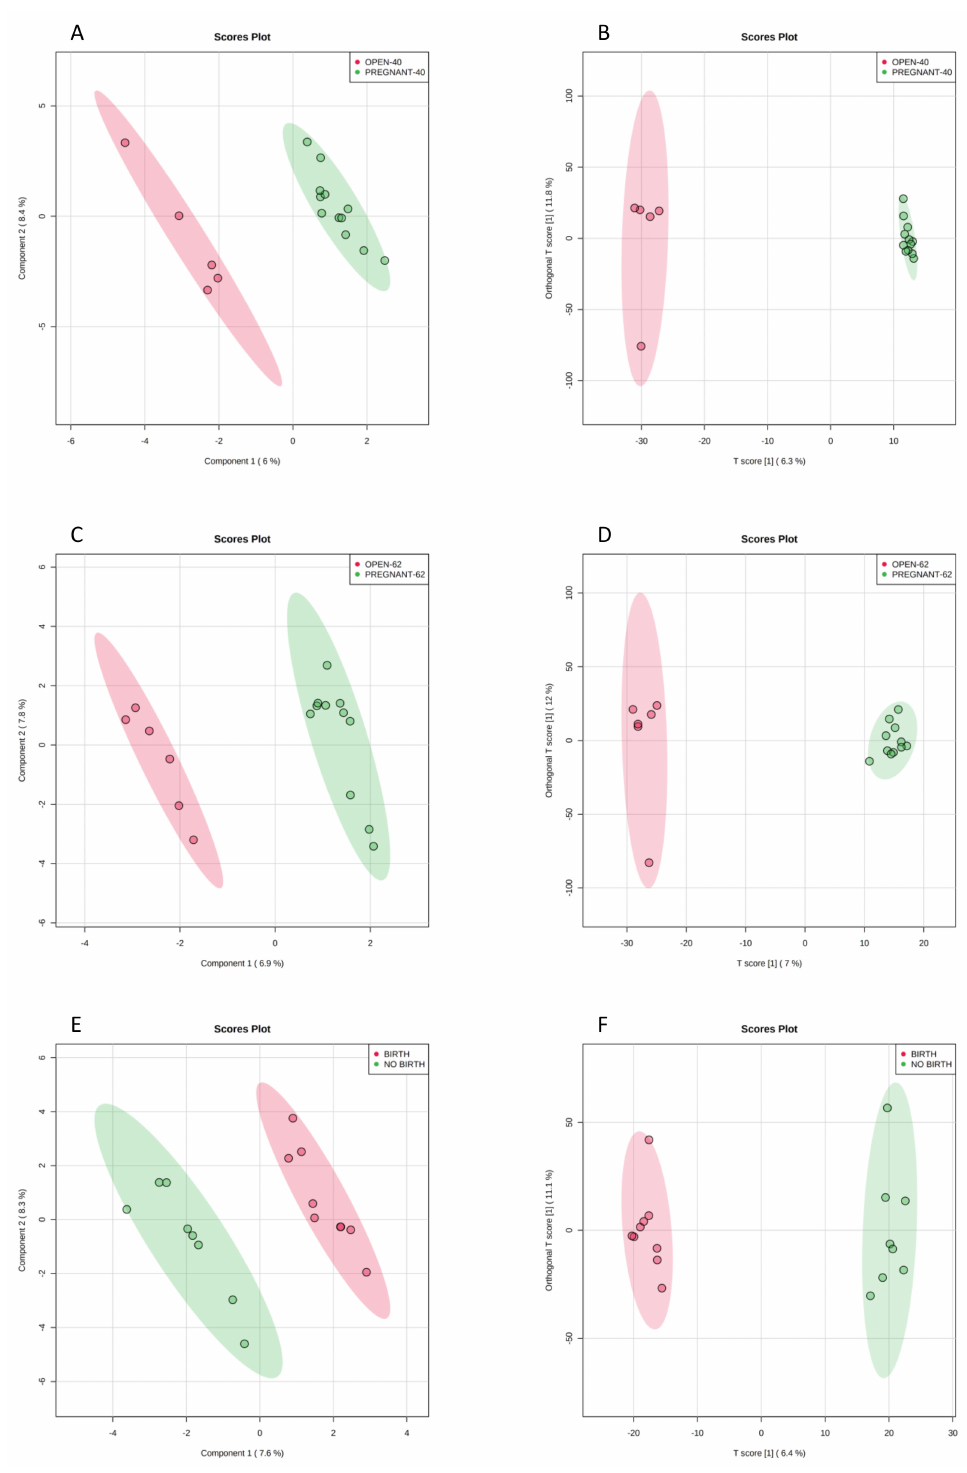
Figure 3. Separation of fresh embryos cultured with BSA was predictive of pregnancy at Day-62 ( C , D ) (Q2: p < 0.07, R2Y: p < 0.04), although not for pregnancy at Day-40 ( A , B ) and birth ( E , F ) (Q2 and R2Y > 0.10). Empirical p -values were obtained after 100